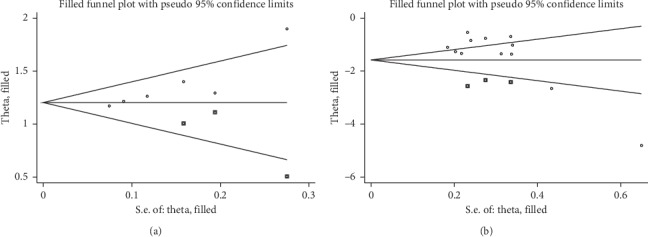
Filled funnel plot. (a) The effective rate of cardiac function. (b) HAMD scale.